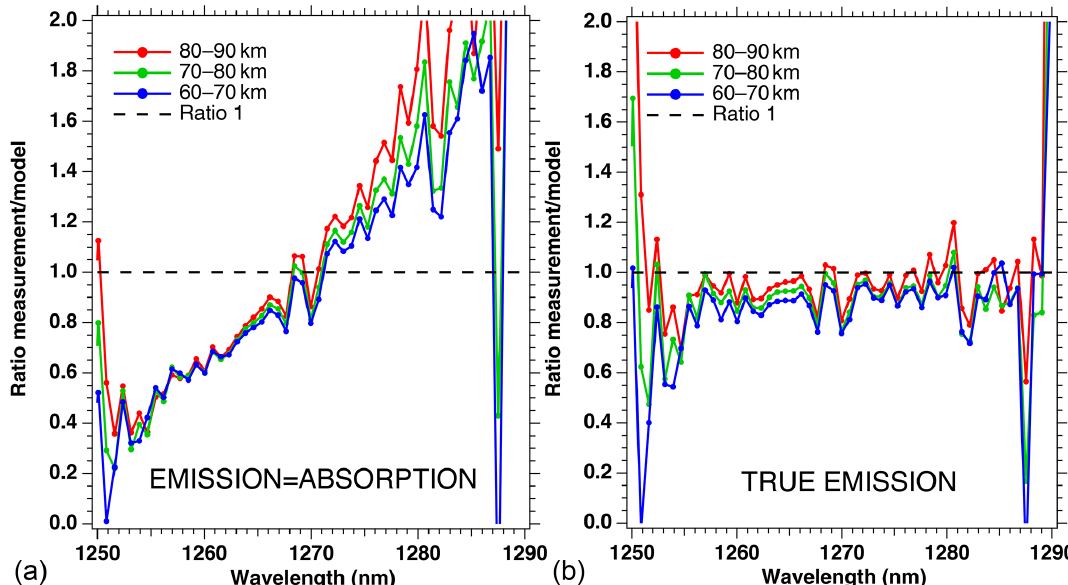
Figure 5. Ratios of measured spectra / model spectra of limb spectra, averaged over a whole Envisat orbit, and binned by altitudes (60–70, 70–80, and 80–90km). (a) Crude model in which the shape of the emission of O 2 ∗ is identical to the absorption by O 2 . (b) Same ratios with our new model described in Appendix A. The ratios are closer to 1 for larger altitudes because absorption by O 2 is neglected in this particular exercise.